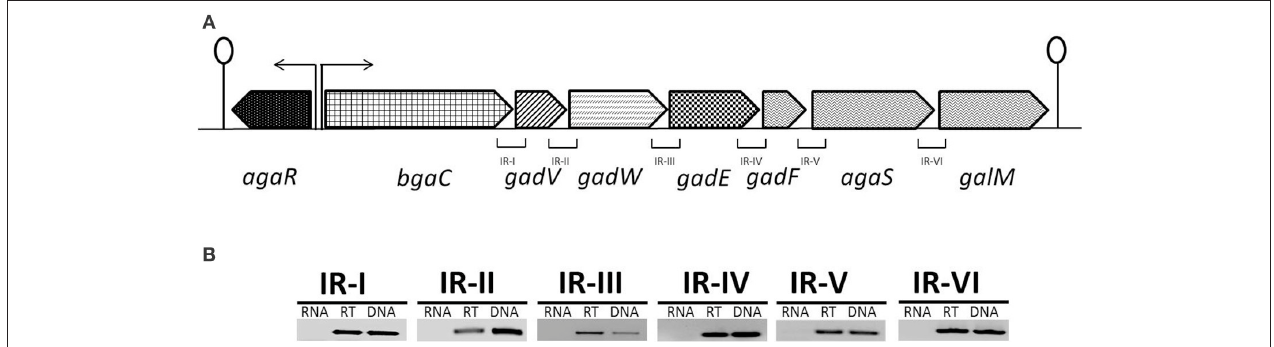
FIGURE 1 | (A) Organization of the aga operon in S. pneumoniae D39. A lollipop structure represents a putative transcriptional terminator, while black arrows indicate the promoter regions. See text for further details. (B) Reverse transcriptase (RT)-PCR analysis to confirm the polycistronic nature of the aga operon in S. pneumoniae D39. RT-PCR was performed on total RNA isolated from S. pneumoniae D39 wild-type grown in NAGaM17 (0.5% NAGa + M17) medium with (RT) and without (RNA) reverse transcriptase treatment using the intergenic region primer pairs. DNA was used as a positive control. The size of the RT-PCR products ranges from 100 to 300bp.